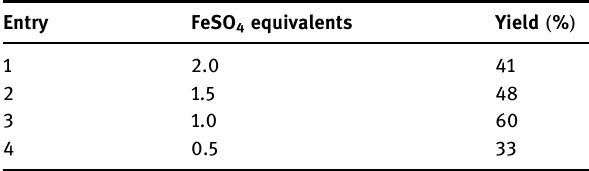
Table 1: E ff ect of varying Fe ( II ) on reaction